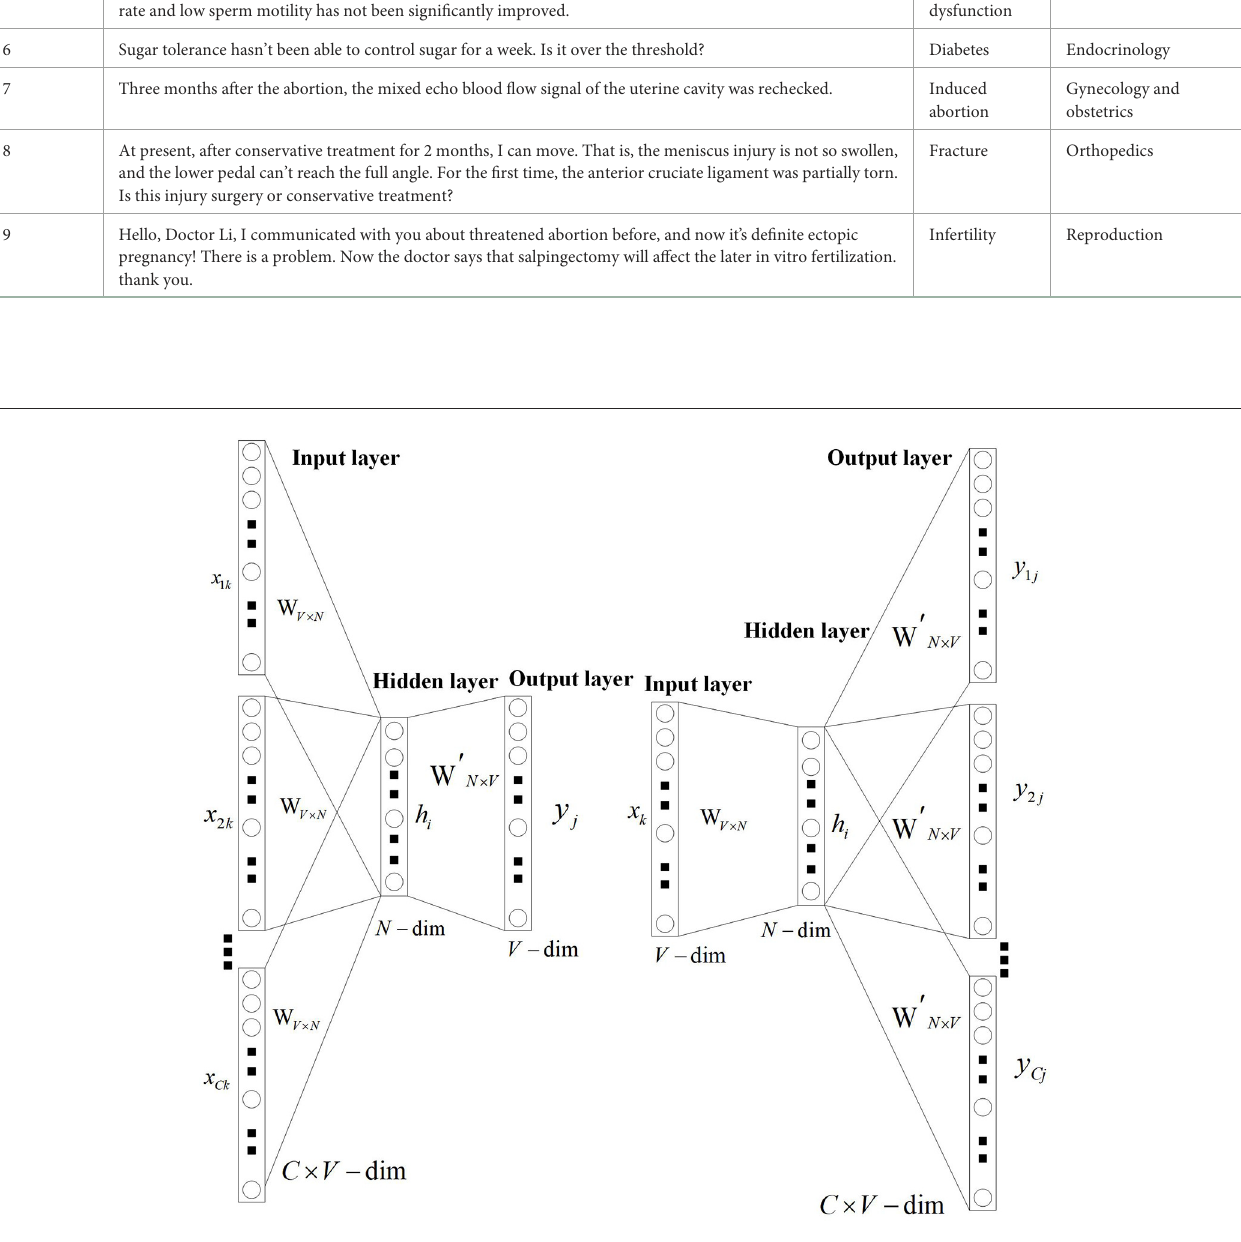
FIGURE2 Word vector